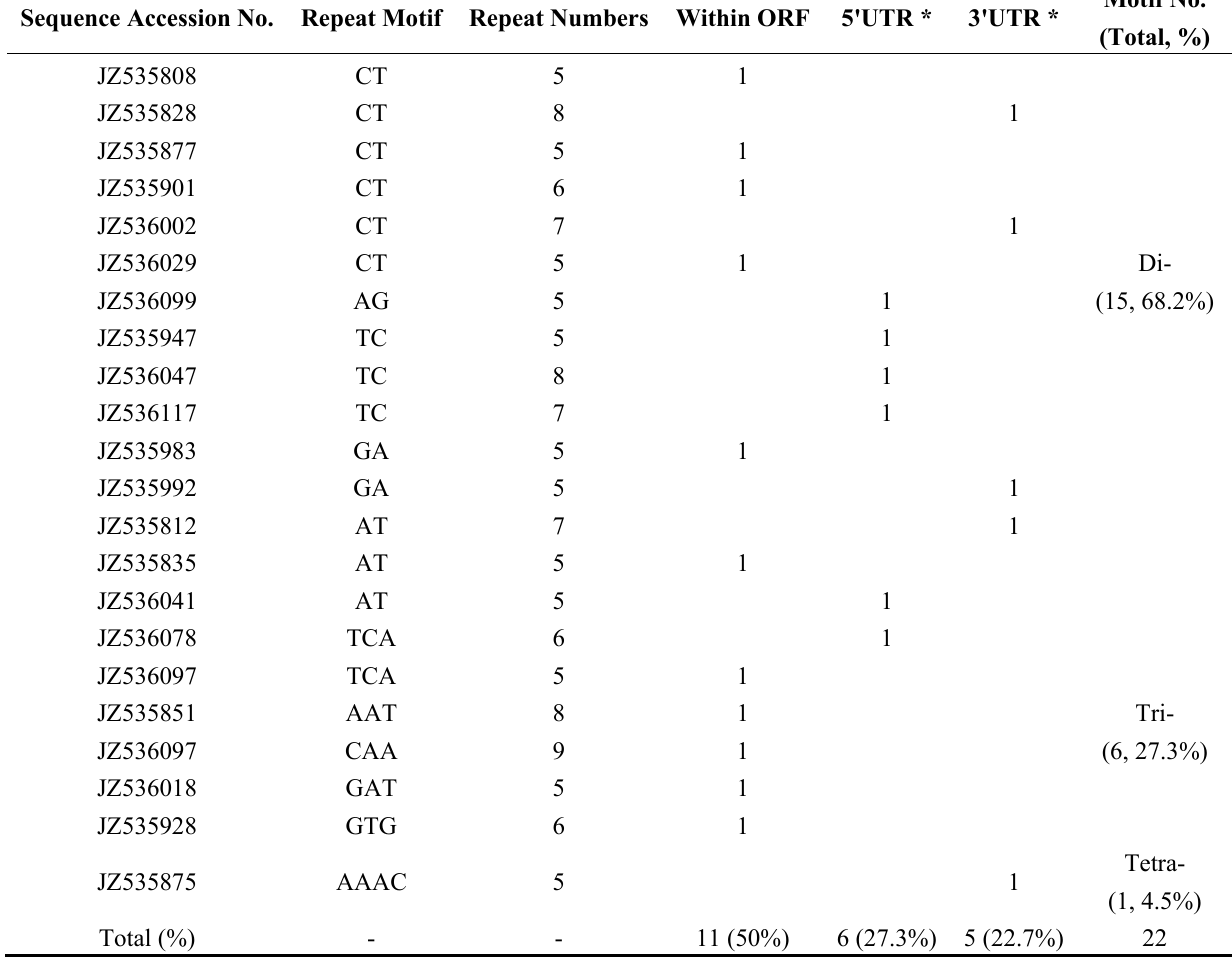
Table 2. Frequency of EST-SSRs found in dbEST sequences and Distribution of SSRs with respect to putative open reading frames